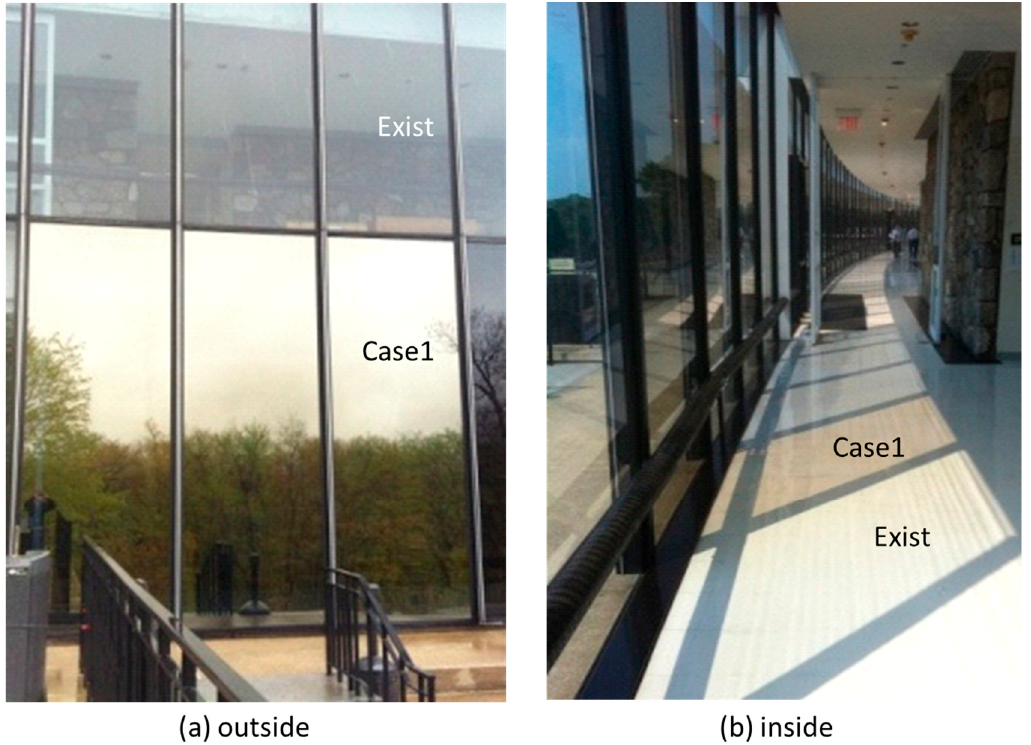
Figure 6. Mock ‐ up implementation for Case 1.